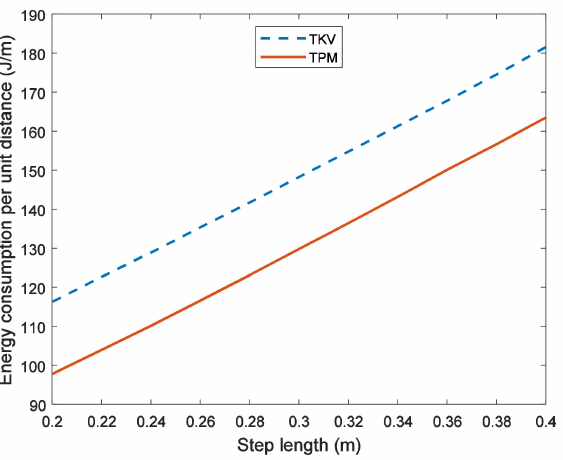
Figure 11. Energy consumption of two gait patterns with different step lengths when T c = 1.0